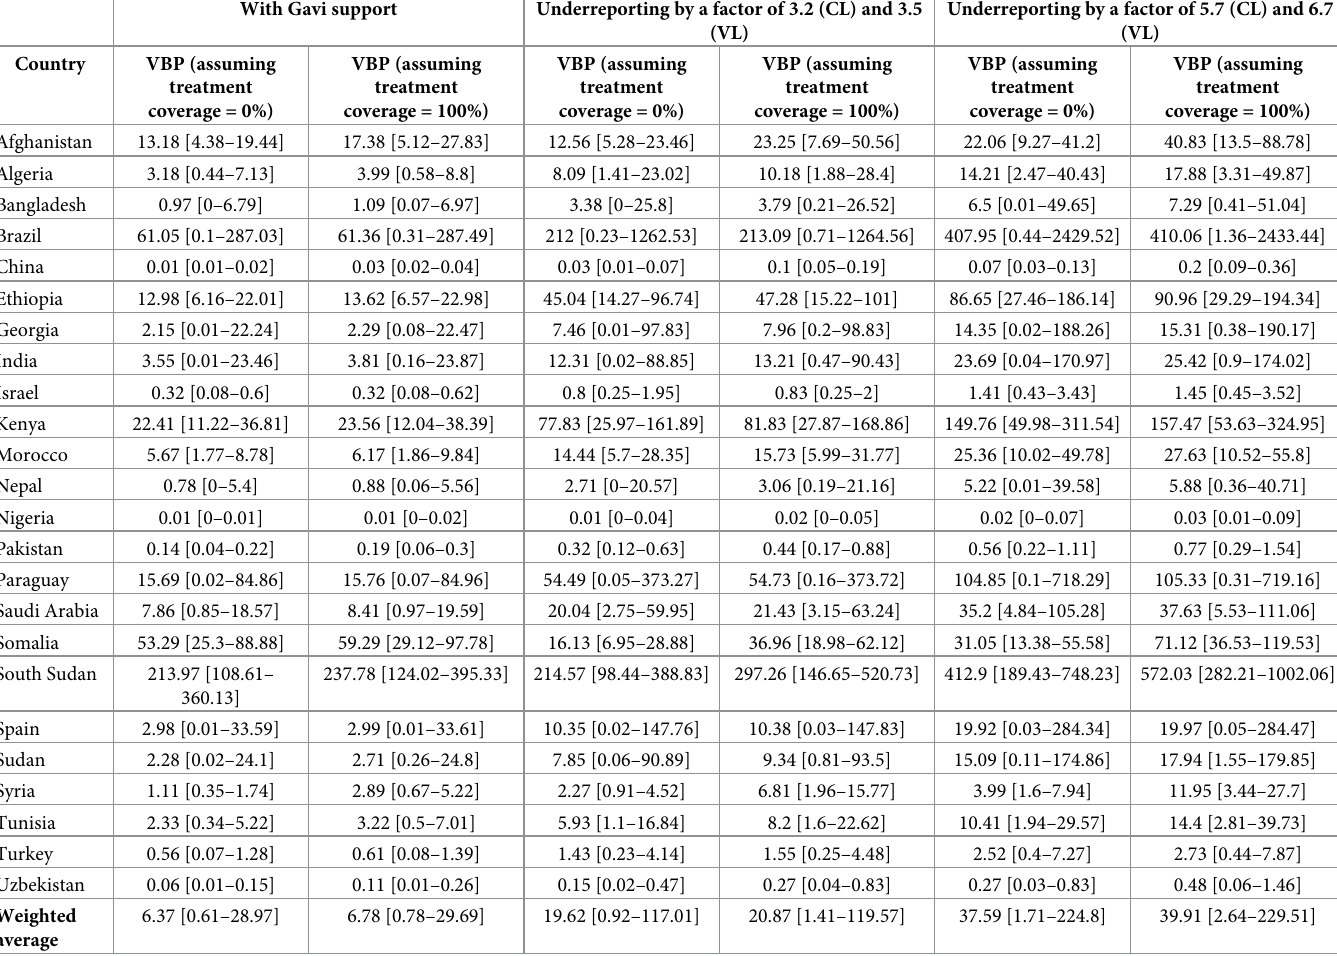
Table 4. Value-based maximum price for a leishmaniasis vaccine course (2030–2040)–Sensitivity analyses.